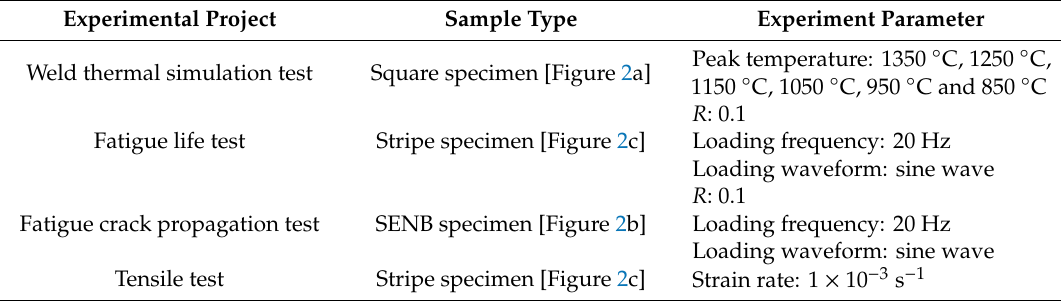
Figure 2. ( a ) Geometry of the thermal cycling simulations test; ( b ) Geometry of fatigue crack propagation test; ( c ) Geometry of fatigue life and tensile test specimens. Table 2. Experimental projects and parameters in this study.